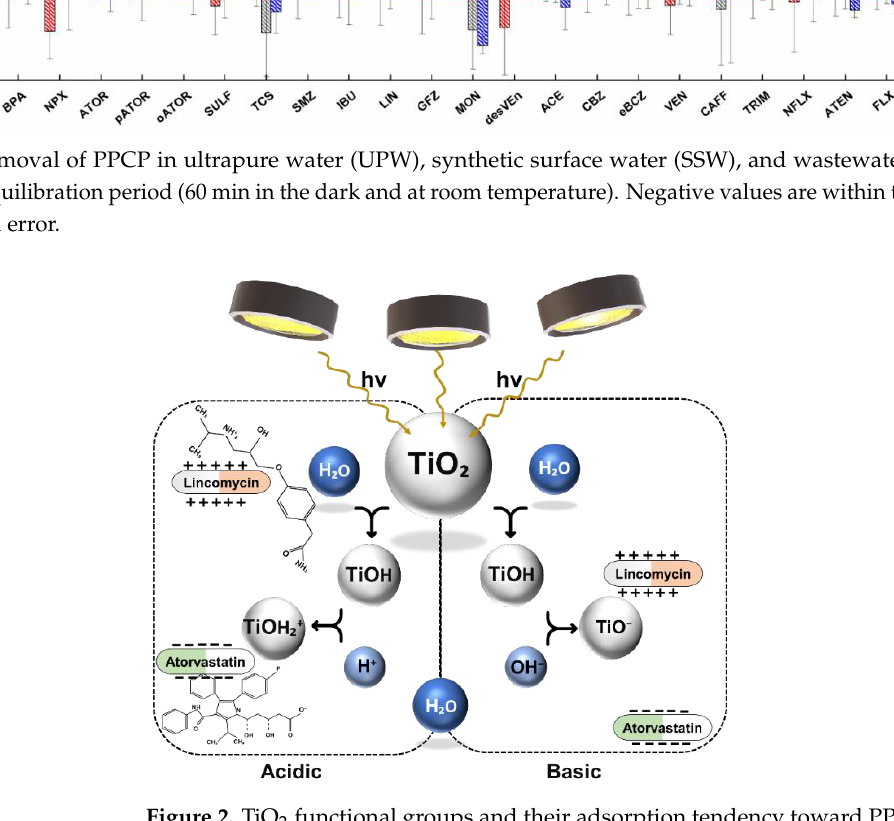
Figure 2. TiO 2 functional groups and their adsorption tendency toward PPCPs in acidic and basic environments. In acidic conditions, negatively charged PPCPs tend to sorb to TiOH 2+ (e.g., atorvastatin), whereas in basic conditions, positively charged PPCPs tend to interact with TiO − . See Figure 1 for the adsorption results of other target compounds. Table 1. Average water-quality characteristics of synthetic surface water and wastewater effluent.